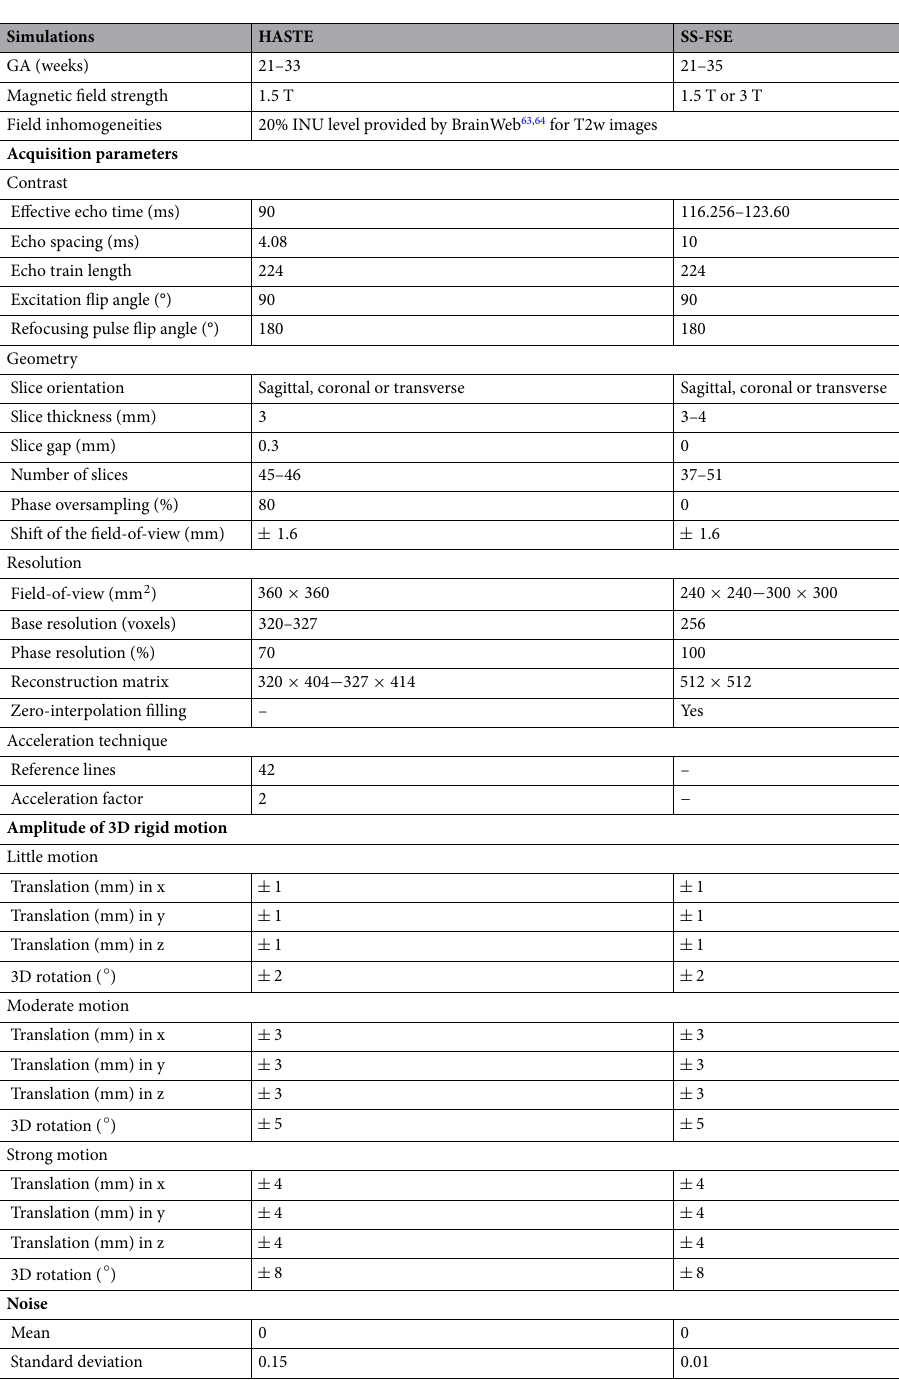
Table 2. The flexibility of FaBiAN is illustrated by the number of sequence parameters and settings available to the user. The ranges of values used to simulate fetal brain MR images are presented, in agreement with the clinical protocols respectively in place at CHUV (HASTE sequence) and Kispi (SS-FSE sequence). The differences in the implementation of both sequences mainly rely on the simulation of the GRAPPA acceleration technique for the HASTE, which affects the way the k-space of the simulated images is sampled, and the simulation of the scanner in-line interpolation for the SS-FSE, which requires low-pass filtering before zero-interpolation filling of